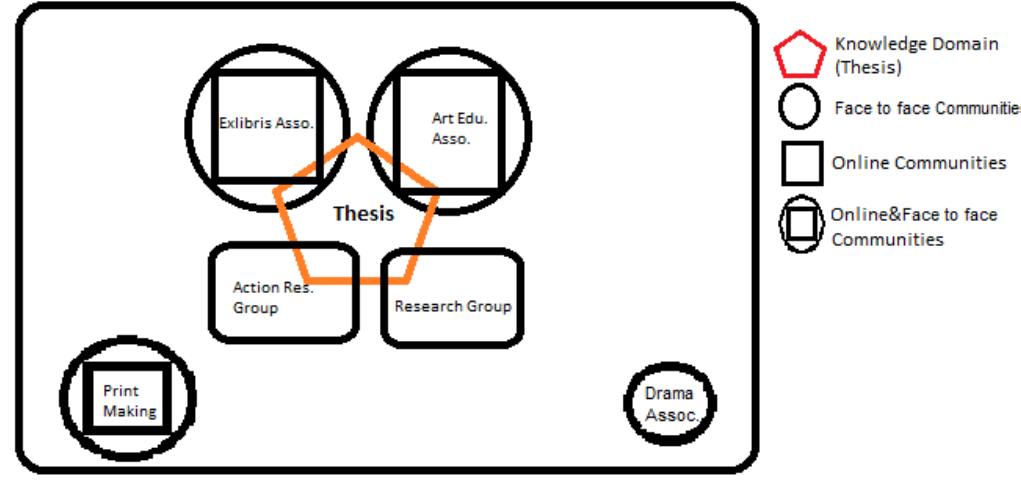
Figure 1 . Multiple communities in which Participant 1 is